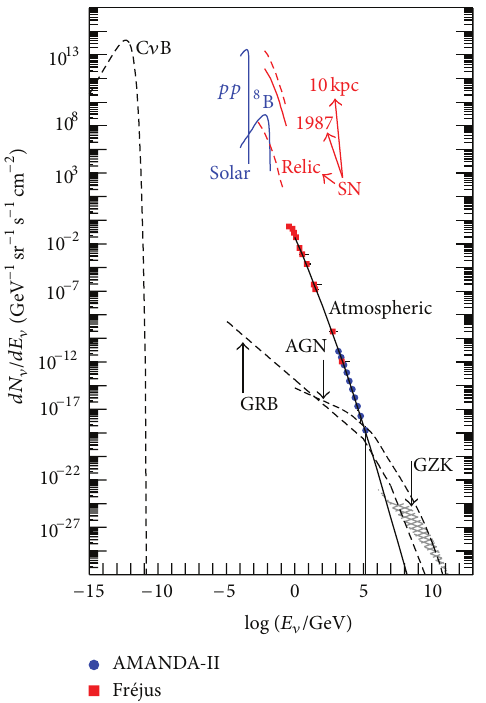
Figure 1: The cosmic-neutrino spectrum. Sources are the Big Bang (C 𝜈 B), the Sun, supernovae (SN), atmospheric neutrinos, active galactic nuclei (AGN) galaxies, and GZK neutrinos. The data points are from detectors at the Fr´ejus underground laboratory [24] (red) and from AMANDA [16]